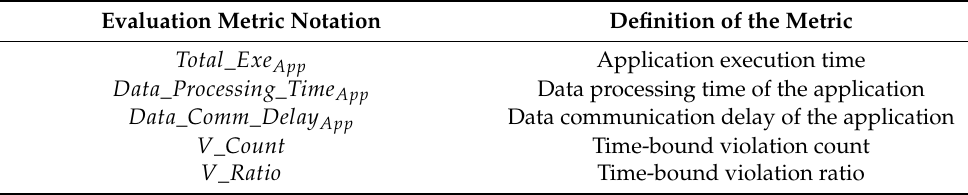
Table 5. Evaluation